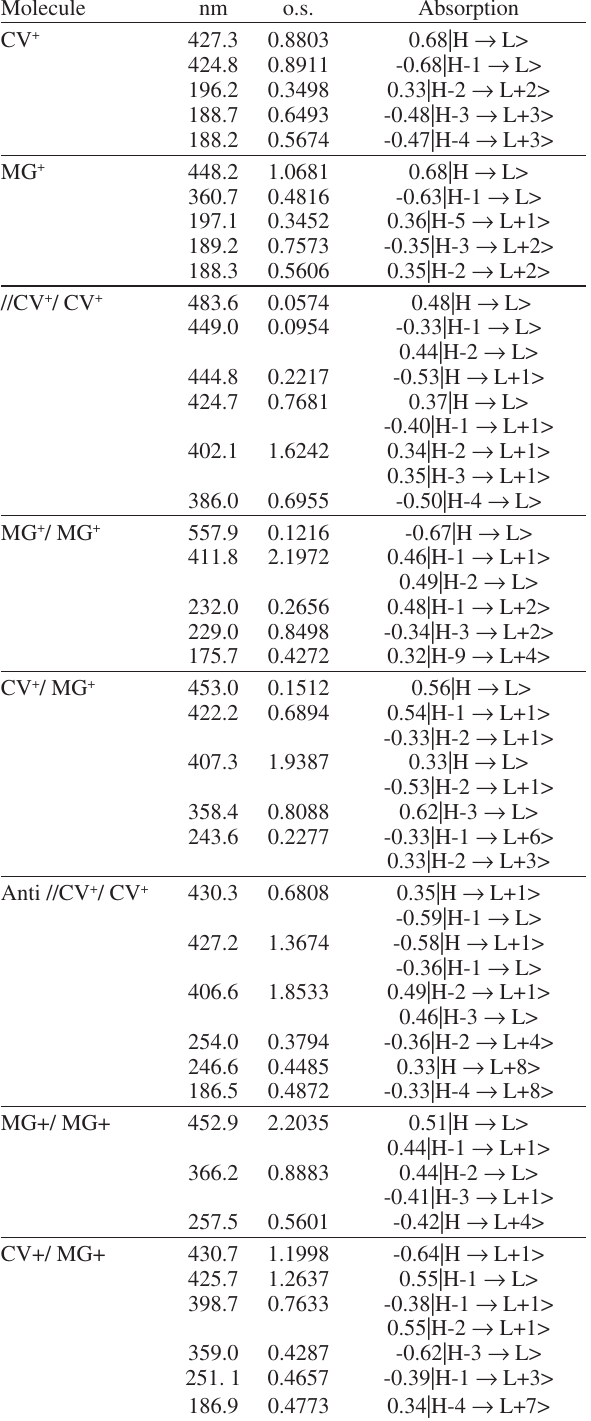
Table 1. Main electronic transitions as determined from INDO/S-CI calculations based on optimized ground-state geom- etry by semiempirical method. (nm, o.s., // and anti-// mean the wavelength of transition, the oscillator strength, the parallel and anti-parallel interaction between the molecules, respectively.)